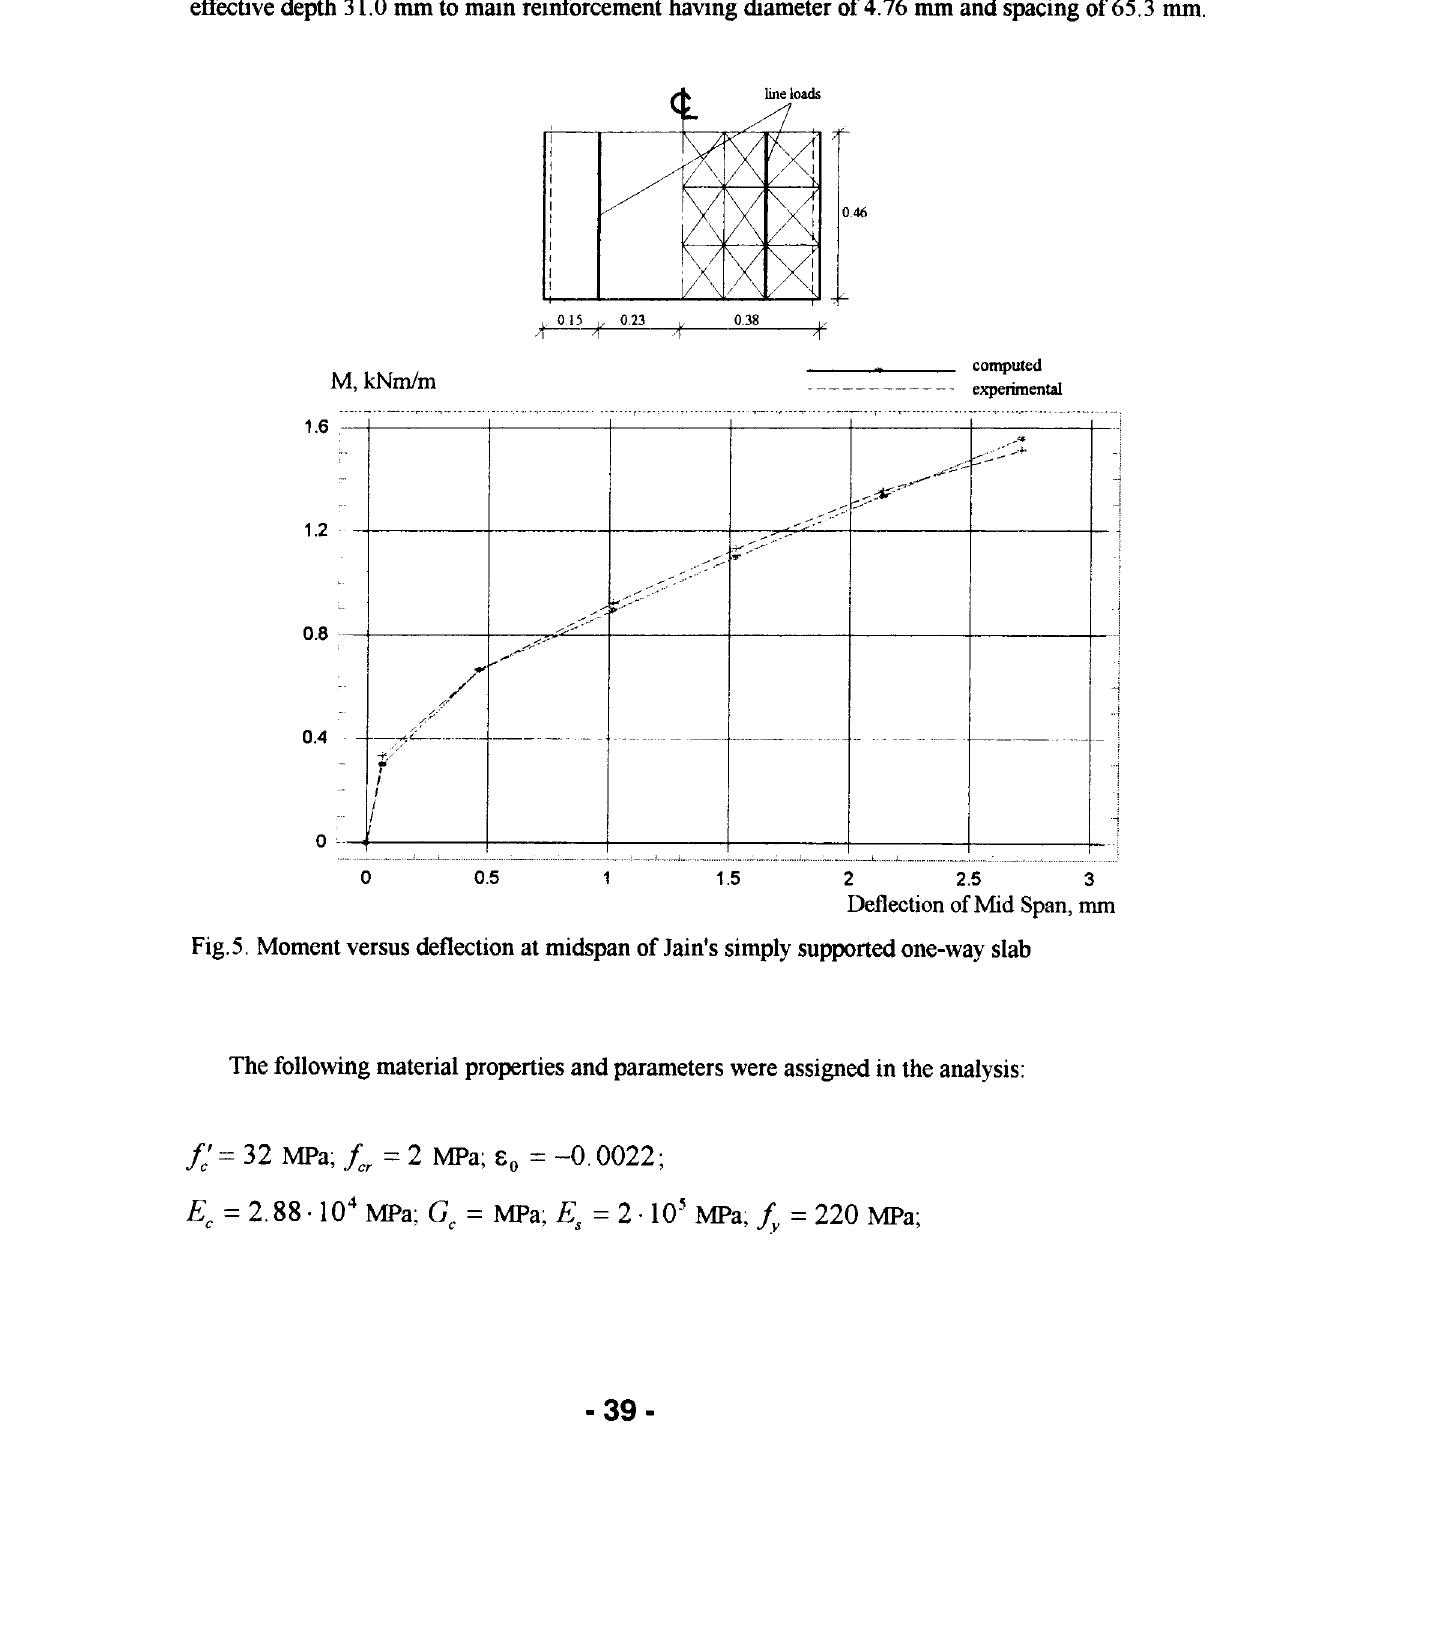
The following material properties and parameters were assigned in the